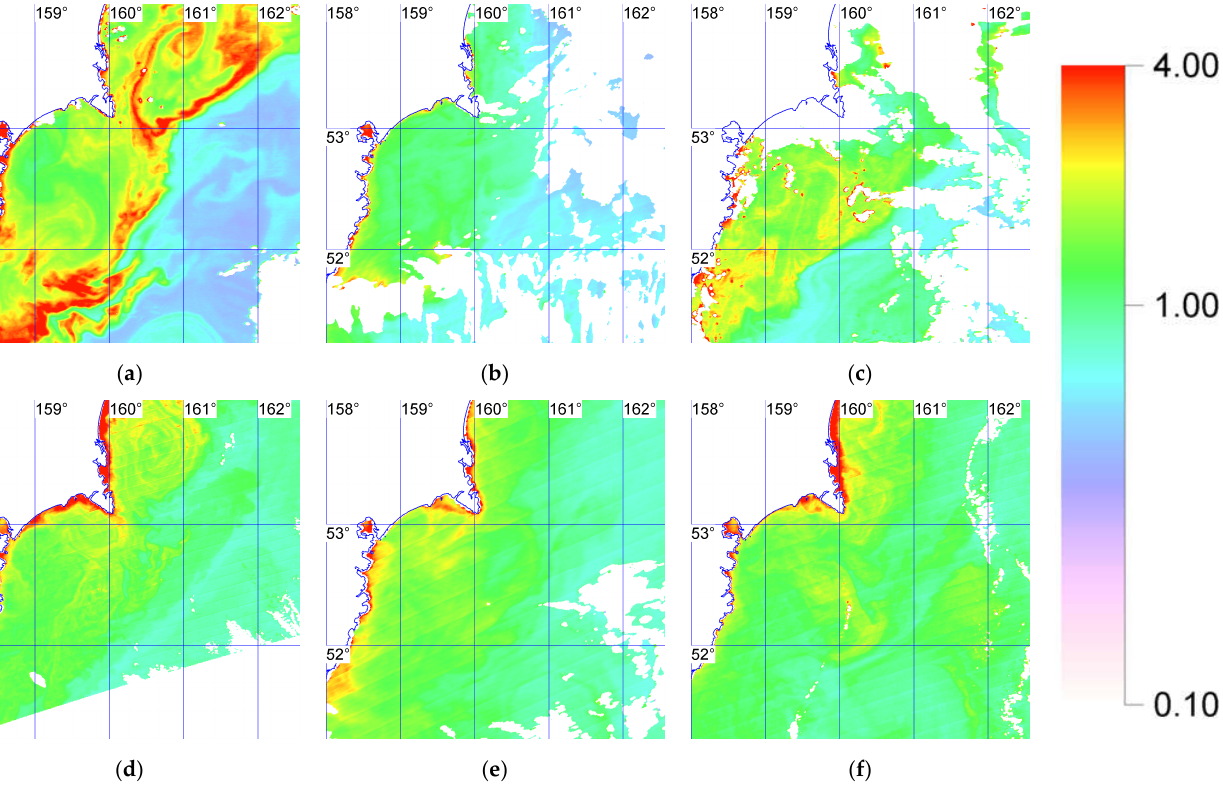
Figure 2. Chlorophyll-a concentration (mg∙m −3 ) in the Avacha Gulf for the following dates: ( a ) September 9, ( b ) September 21, ( c ) September 25, ( d ) October 3, ( e ) October 9, ( f ) October 12. MODIS/AQUA. Table 2. Variability of average values of bio-parameters in the Avacha Gulf in coastal and open- ocean zones.